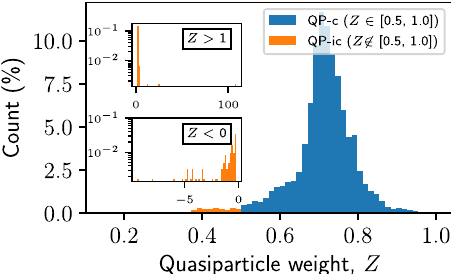
Fig. 2 Quasiparticle weights. Histogram of QP weights, Z , for the 61716 QP states in the C2DB 40 . The Z values have been extrapolated to the in fi nite plane-wave limit (see next section). The main panel shows the distribution of Z values within the range, Z ∈ [0, 1], while the upper and lower insets show the distribution outside the physical range, i.e., Z > 1 and Z < 0, respectively. 0.16% of points lie in the Z > 1 range, while 0.12% lie in the Z < 0 range.